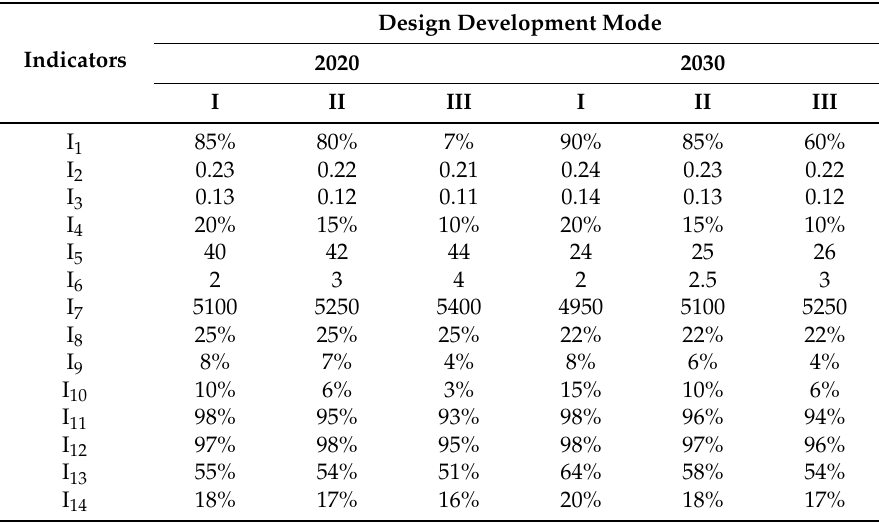
Table 4. Indicator values of WRDCC of Chengdu